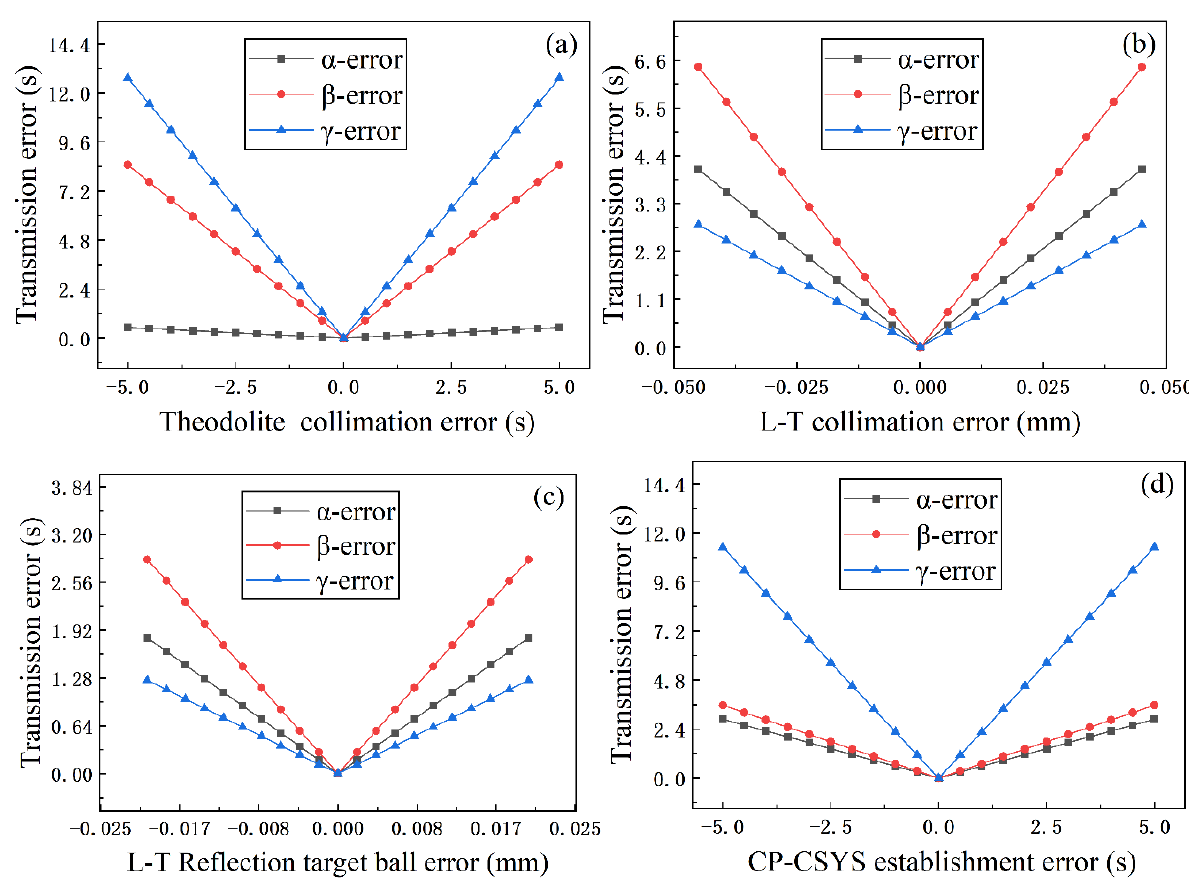
Figure 8. The effect of a single error on transmission accuracy: ( a ) theodolite collimation error; ( b ) laser tracker collimation error; ( c ) laser tracker reflective target sphere manufacturing eccentricity error; ( d ) cubic prism coordinate system establishment error.